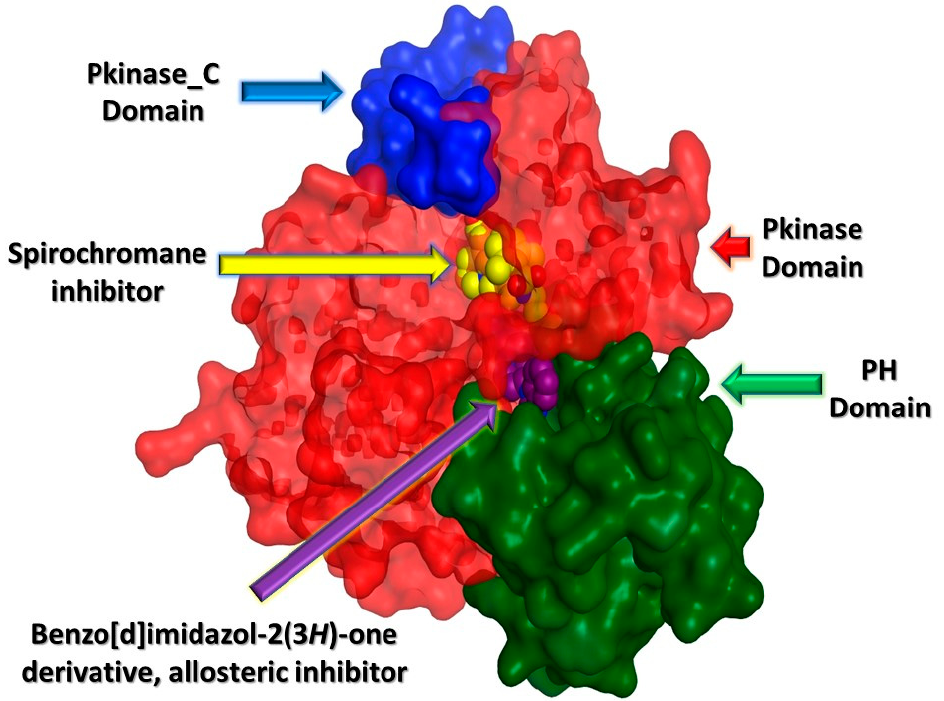
Figure 11. 3D structure of the AKT1 protein wherein there is a Pleckstrin homology domain (green), protein kinase domain (red), and protein kinase C terminal domain (blue). AKT1 activity can be inhibited by two modes: inhibitors of the active site and allosteric inhibitors. From the literature survey, both coumarin and cinnamic acid scaffolds have potential PI3K/AKT1 signaling pathway inhibitory action [64–67], and either coumarin derivati- zation or combination with cinnamic acid proposed the final compounds that possess the main pharmacophoric features as the bound ligands in the active site of both PI3K and AKT1. Generally, PI3K and AKT1 inhibitors have a common “hydrophobic-aromatic ring-hydrophobic-HB_A” feature as previously reported [68,69]. Additionally, we found that the optimum length between the hydrophobic moiety and the aromatic ring should be in the range of 3.5–4.0 Å, while the optimum length between the other hydrophobic moiety and the HB_A group should be in the range of 3.0–3.5 Å. By superimposing the proposed compounds ( 4 , 8a , 8b , 8c ), we found that all of the compounds fulfilled the re- quired pharmacophoric features to act as PI3K/AKT1 inhibitors. Furthermore, compounds that had bromo-substitutions at positions 3,6,8 of the coumarin ring can form additional weak H-bonds or halogen bonds depending on the bond distances and angles with the adjacent amino acid residues as previously described [70,71]. This results in the stronger embedment of bromo-compounds in the kinase domains of the studied proteins (Figure